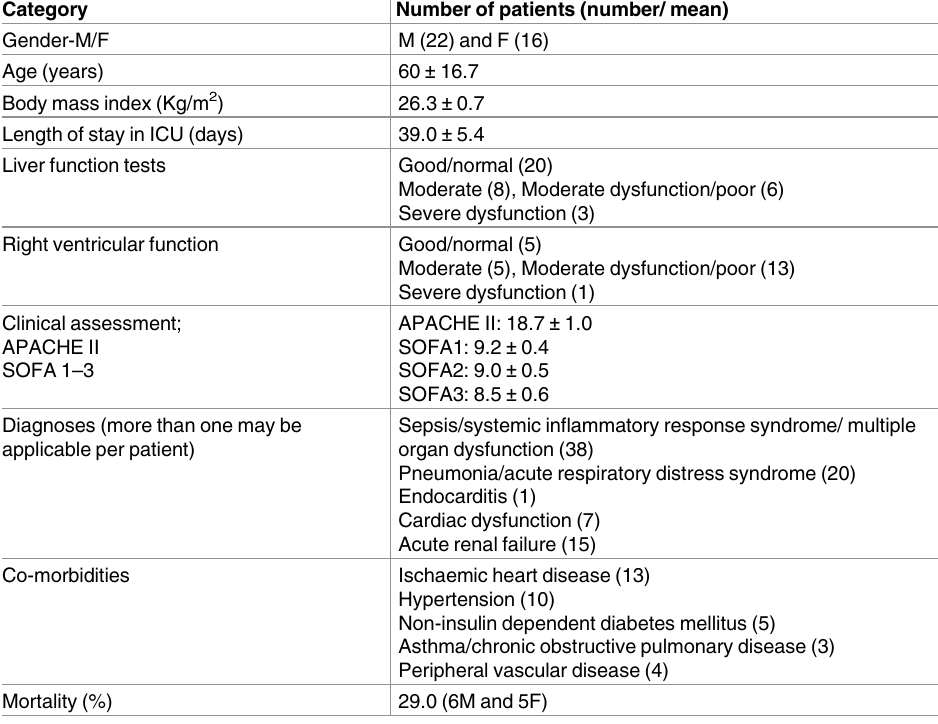
Table 1. Patient demographics. Basic clinical information of patients with sepsis involvedin the study is shown. Abbreviations for clinicalassessments are APACHE II = Acute Physiologyand ChronicHealthEvalua- tion and SOFA = SequentialOrgan Failure Assessment score. Data are shown as individualnumbers for n = 38 for patients with